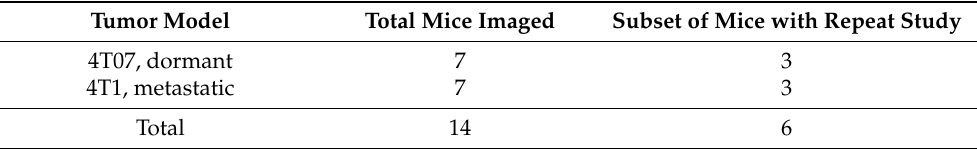
Table 4. Study design